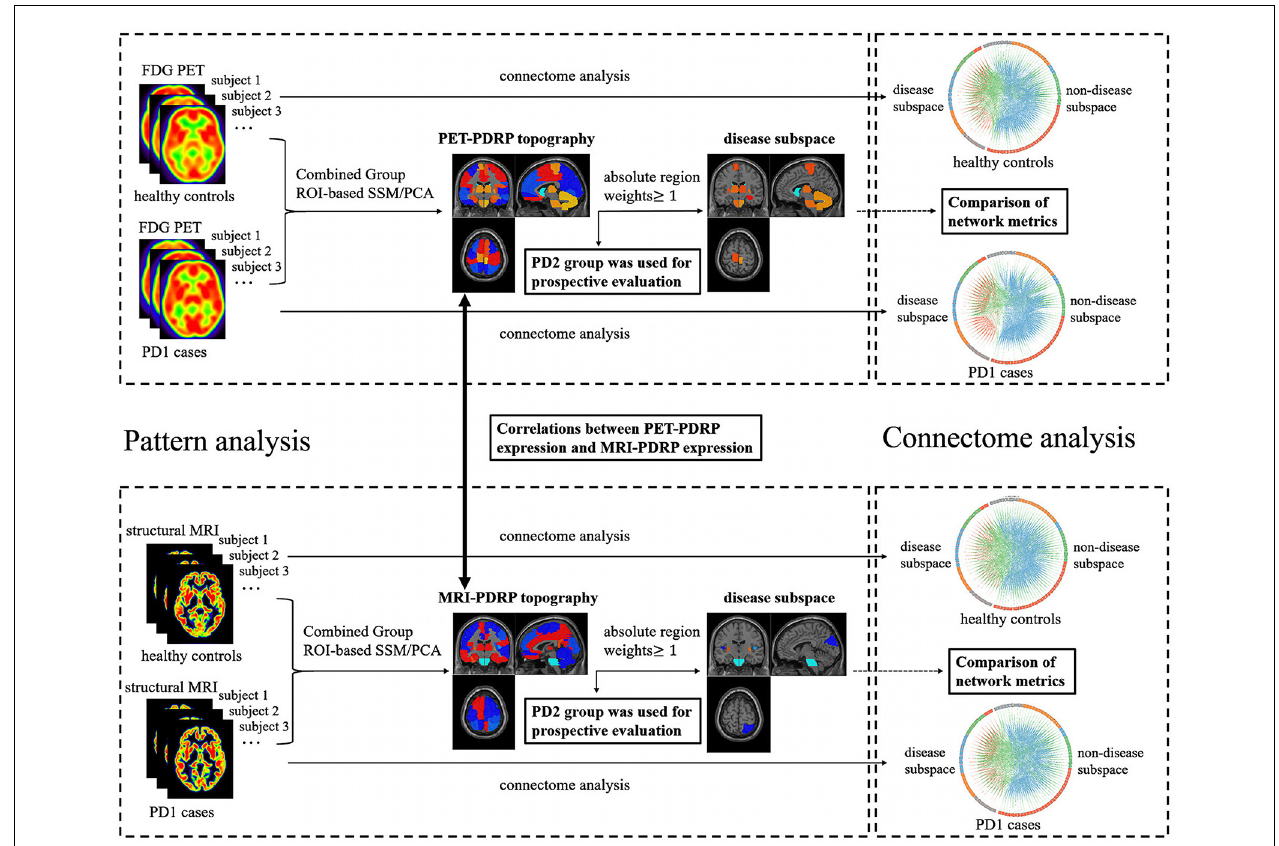
FIGURE 1 | The overall framework of the experimental process used in this study.